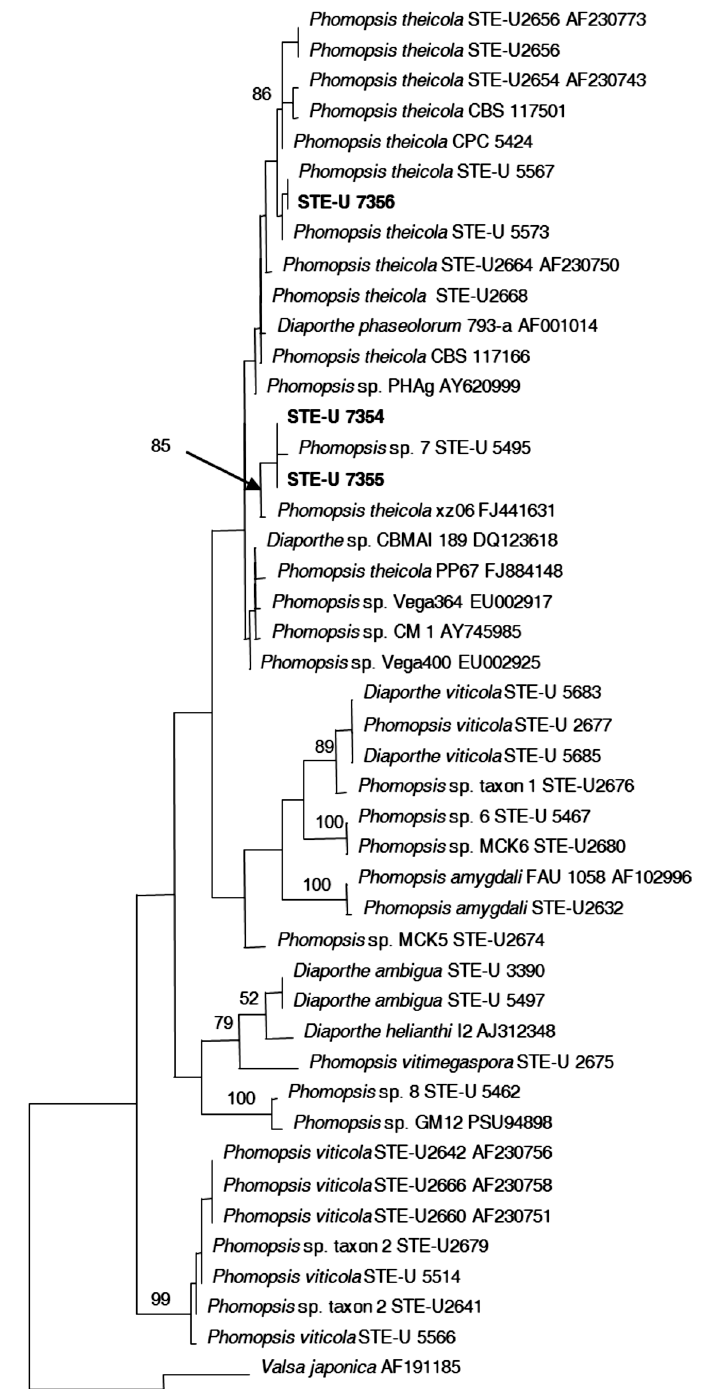
Figure 2. One of 150 most parsimonious trees obtained from ITS sequences of the Phomopsis isolates . Bootstrap sup - port values above 50% from 1000 replicates are shown at the nodes. Tree scores include TL = 246, CI = 0.675, RI = 0.841, RC = 0.568, HI = 0.325. Isolates from the present study in